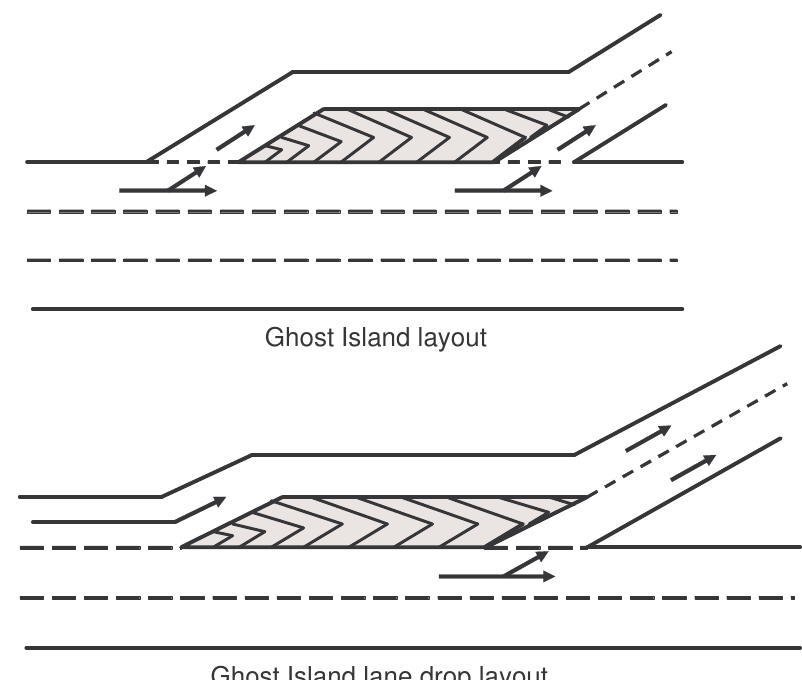
Figure 2. The Ghost Island diverge layouts (from Wall and Hounsell,